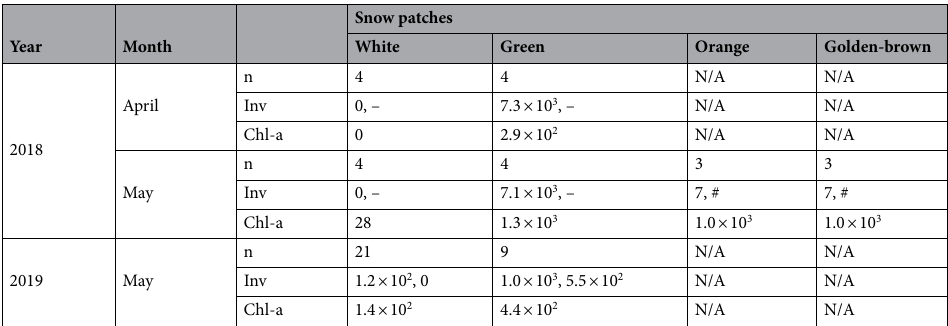
Table 1. Number of snow samples, population density of microinvertebrates and concentration of chlorophyll a . Inv.: population density of microinvertebrates (tardigrades or rotifers, ind L − 1 chlorophyll a ( µ g L ), N/A: colored snow was absent, # : rotifers were present but not